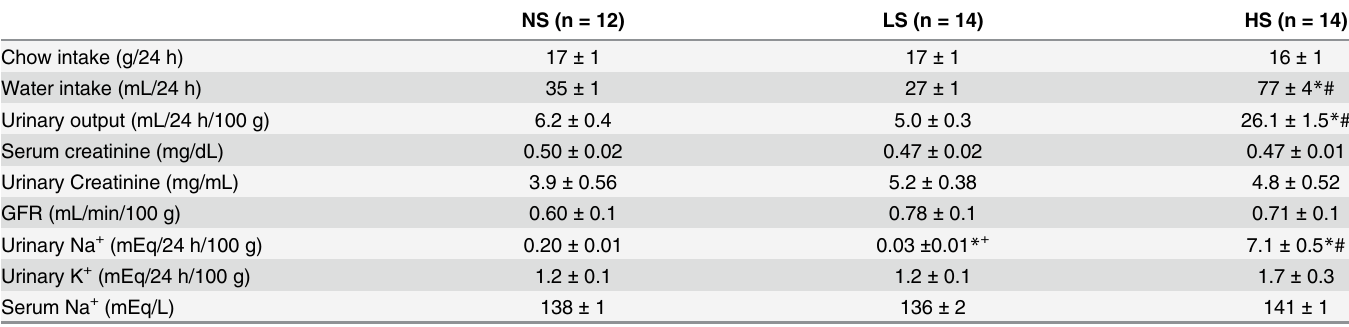
Table 2. Parameters of renal function.